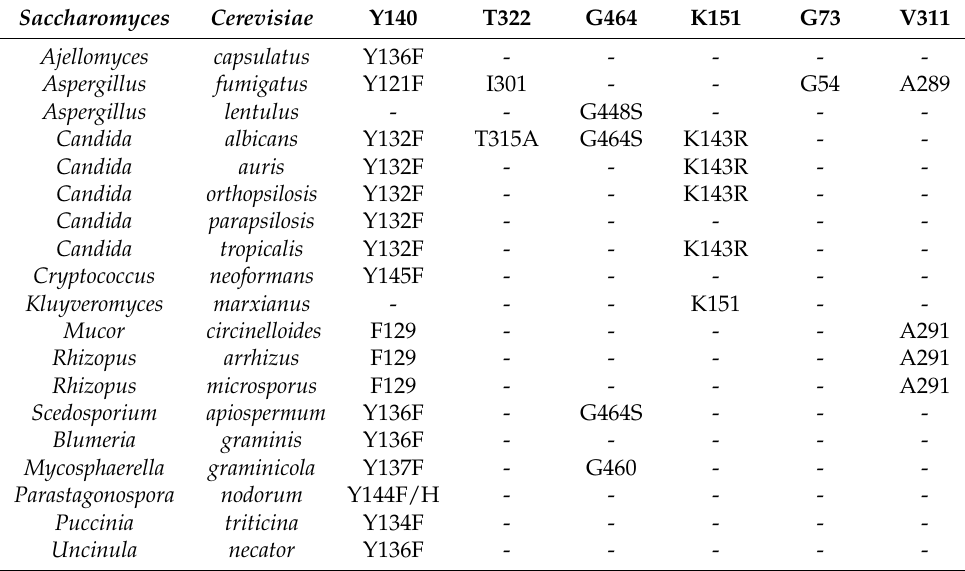
Table 2. Relevant amino acids (AAs) in the ligand-binding pocket of sterol 14 α -demethylase based on Saccharomyces cerevisiae lanosterol 14 α -demethylase (see Figure 1 and Supplementary Table S2). An overview of mutations in structurally aligned amino acid position in other pathogenic fungi of plants and animals is given